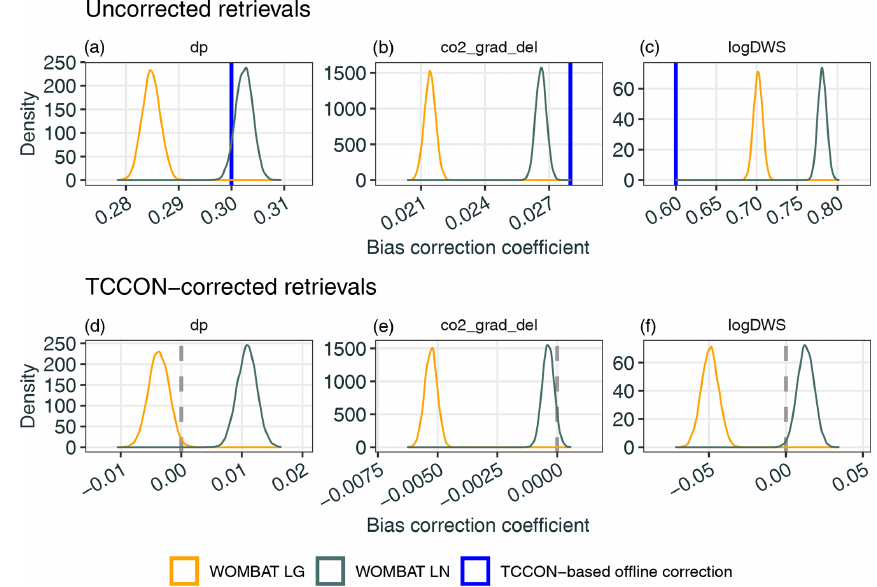
Figure 7. Posterior densities of bias-correction coefficients from inversions using OCO-2 retrievals without bias corrections applied (a, b, c) and those from inversions using retrievals corrected using the TCCON-based offline bias coefficients (d, e, f) . Densities are shown for inversions based on LG and LN retrievals in yellow and dark green, respectively. The TCCON-based offline bias correction coefficients are shown as vertical blue lines for the panels in the top row. The vertical dashed grey lines in the bottom row mark zero, which is the value the coefficients would take if the data were